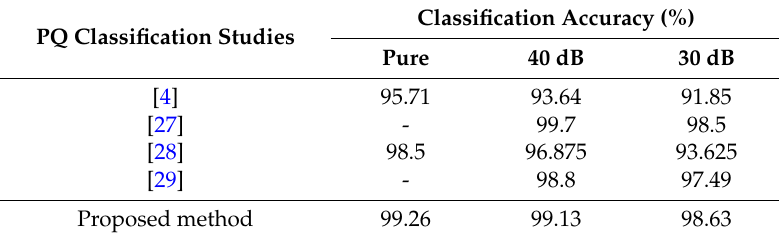
Table 5. Comparison between the proposed algorithm and other algorithms with noise